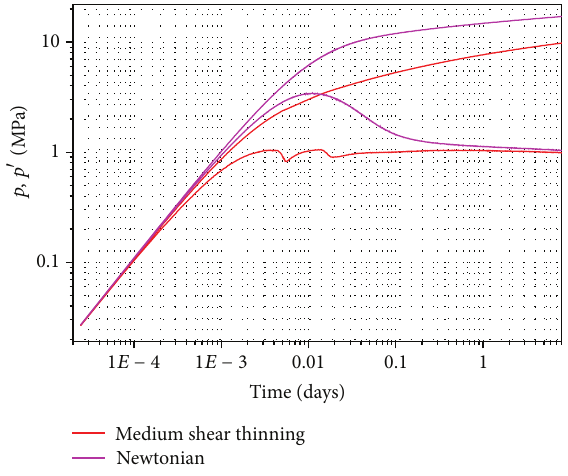
Figure 8: Log-log plot of the well bottom pressure and pressure derivative of the production well for different 𝑀 - 𝑉